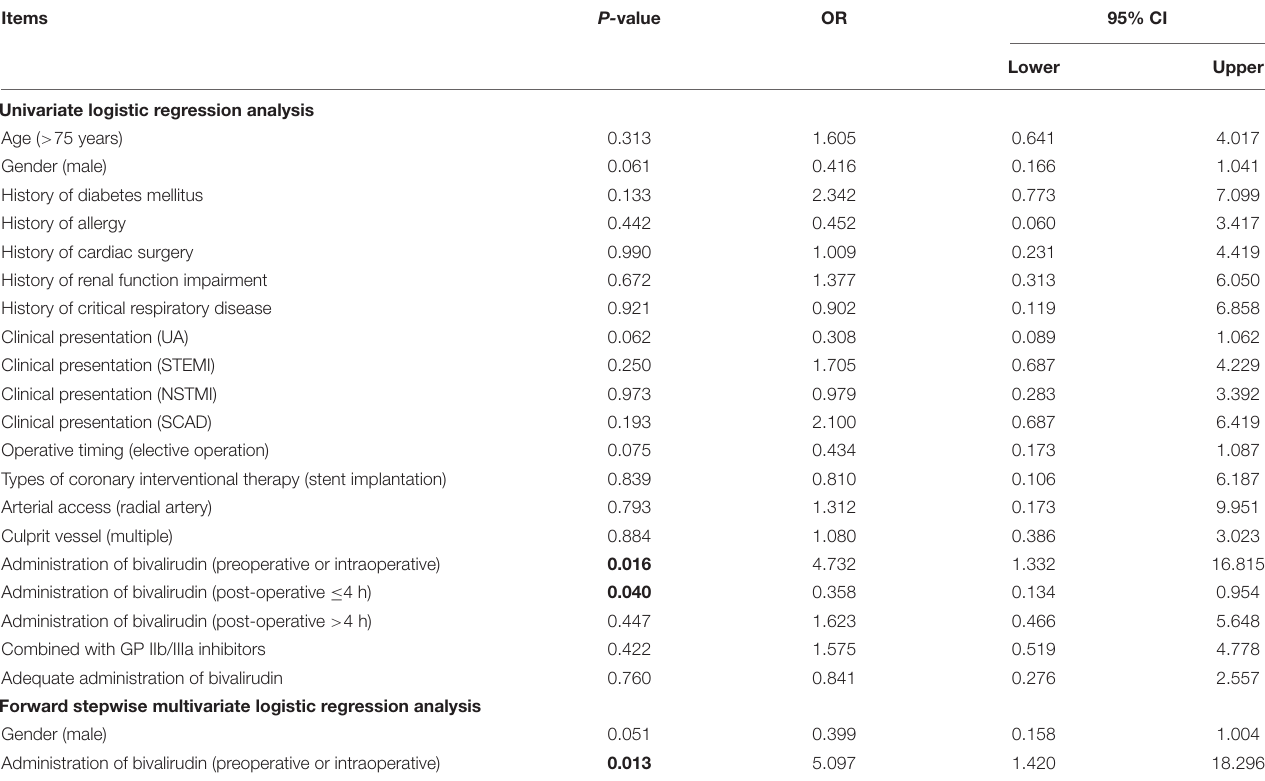
TABLE 5 | Logistic regression analysis for